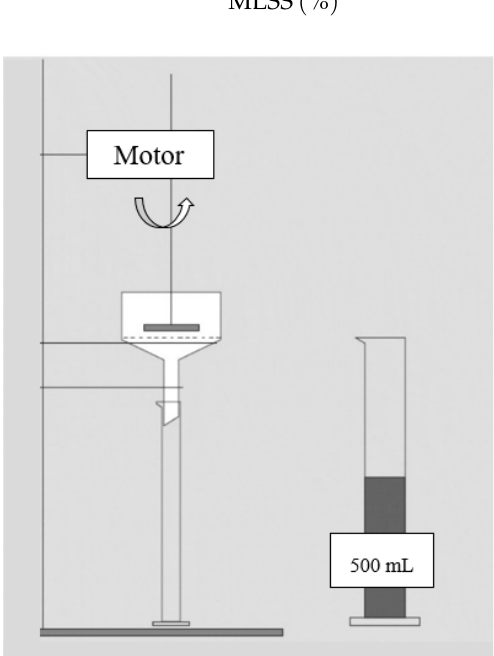
Figure 4. Schematic of the apparatus for measuring the SFI [11].